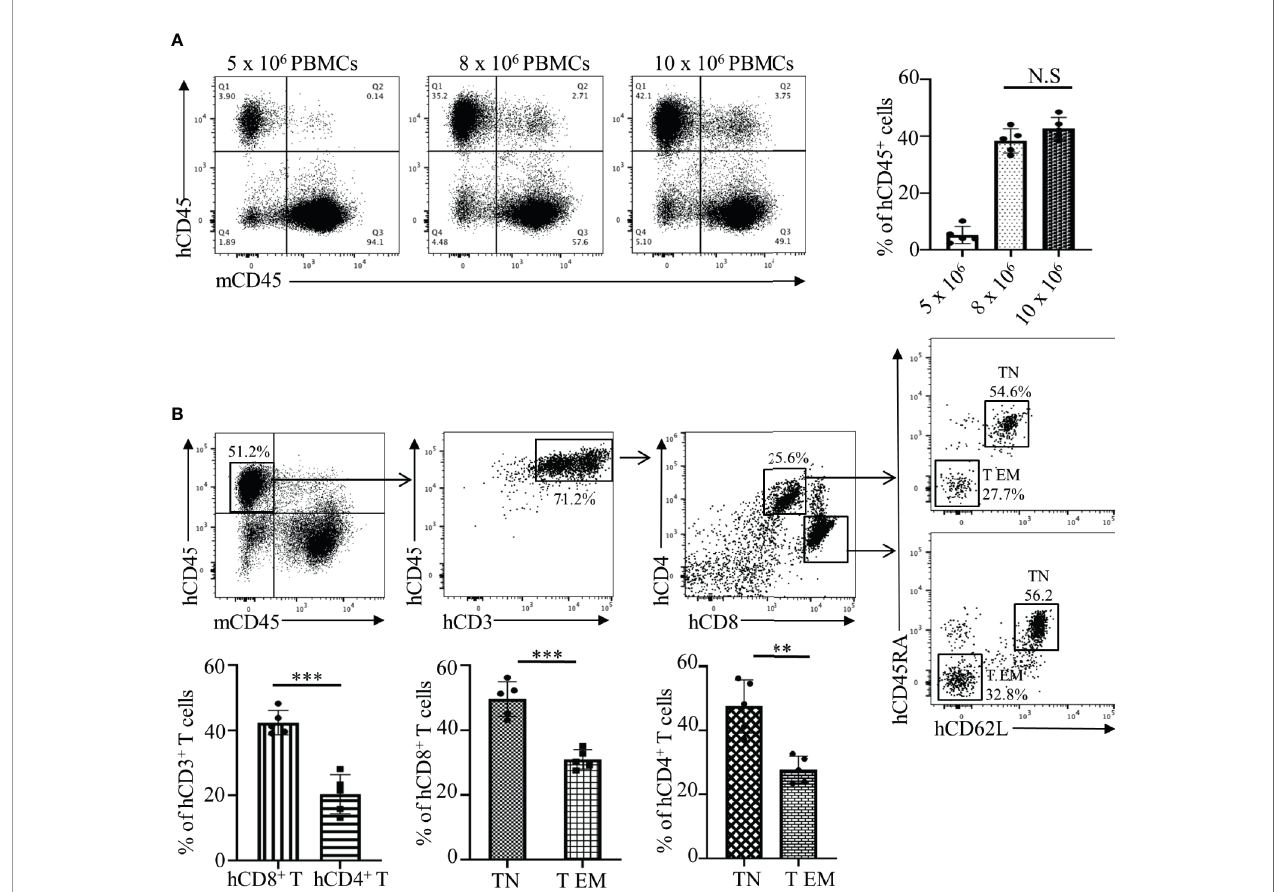
FIGURE 2 | Analyses and optimization of humanization phase in the Hu-NSG-PBMC mouse model. (A) Representative fl ow cytometry dot plots depict engraftment of hCD45 + cells in the humanized mouse 3 weeks after initial dose of 5, 8, or 10 x 10 6 recipient PBMCs. Graphical summary illustrates frequency (%) of recipient hCD45 + cells in the spleen of the humanized mouse (n=5 mice per group). Data presented as mean ± SD. NS., not signi fi cant. (B) Flow cytometry dot plots depict phenotype of the engrafted hCD45 + cells in the humanized mouse with gating for hCD3 + , hCD4 + , and hCD8 + T cell populations. Characterization of hCD4 and hCD8 + T cells was expanded showing their respective CD62L and CD45RA expression. Graphical summary depicts frequency (%) of hCD4 + and hCD8 + T cells as well as percent of TN (CD62L + CD45RA + ) and T EM (CD62L - CD45RA - ) populations. n=5 mice per group. Data presented as mean ± SD. ** p < 0.01, *** p <